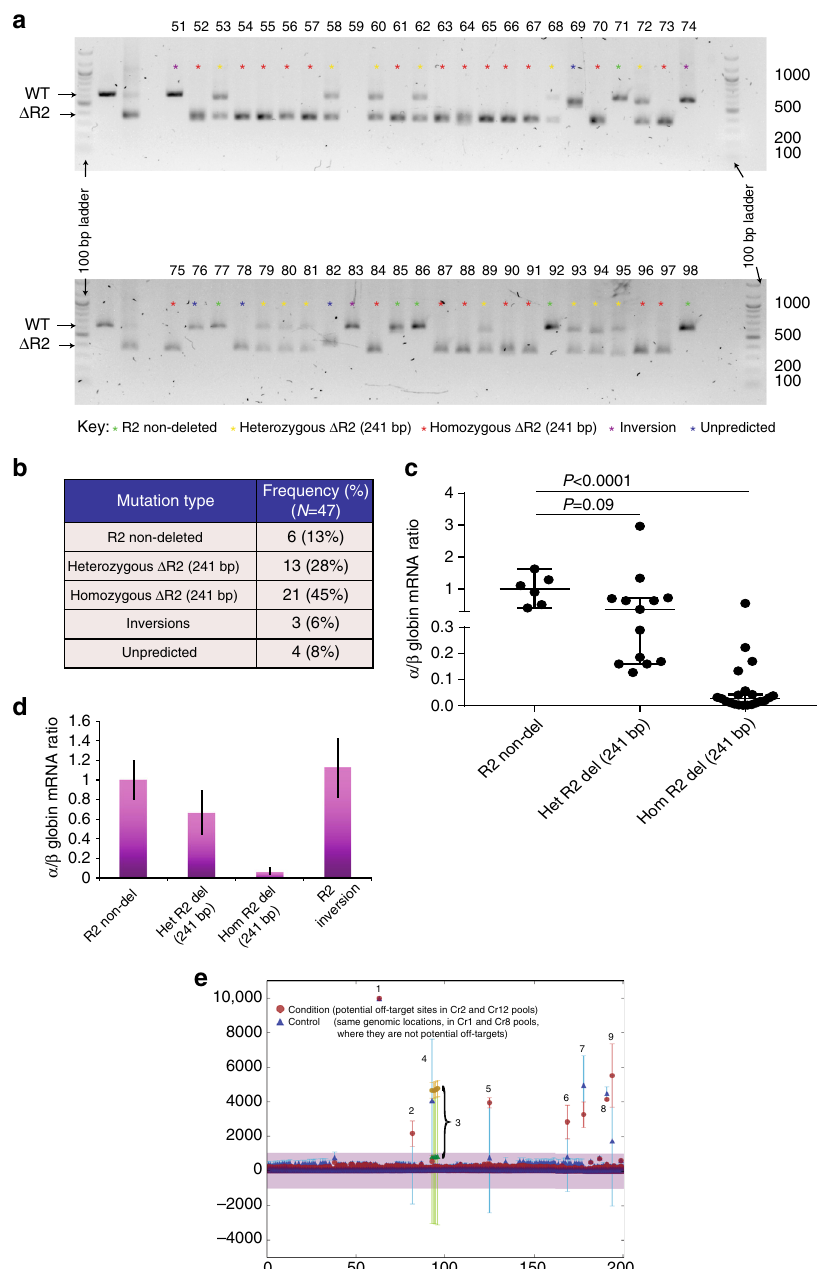
Fig. 3 Single-cell clone analysis of targeted deletion of MCS-R2. a Gel electrophoresis image of genomic DNA from 48 individual single-cell clones genome- edited using CRISPR pair Cr2 and Cr12 (from three biological independent donors) analyzed by PCR. The amplicon from the wild-type allele is 613 bp and the mutated amplicon is 372 bp. Clones are numbered 51 – 98 and clone 59 failed to amplify. Extended genotype analysis of these clones by sequencing is presented in Supplementary Fig. 4. b Frequency of different types of mutations generated. c α / β -globin mRNA ratios of individual clones of erythroid cells which are non-deleted (R2 non-del) ( n = 6) and heterozygous (Het R2 del.) ( n = 13) or homozygous (Hom R2 del.) ( n = 21) for a 241 bp deletion of MCS- R2 region analyzed by qPCR; median ( horizontal bar ) and 95% con fi dence interval ( error bar ) are shown and P -values were calculated using Mann – Whitney U -test. d α / β -globin mRNA ratios of erythroid cells, which has no deletion ( n = 6), heterozygous deletion ( n = 13), homozygous deletion ( n = 21), and inversion ( n = 3) of MCS-R2 analyzed by qPCR. Means and SEM are shown. e Meta-plot of all off-target loci for CRISPR pair Cr2 and Cr12. All captured sites are plotted on the same x -axis, showing ± 100 bases from each potential off-target site. Counts deviating from the reference sequence, which are normalized to 10,000 counts are plotted in the y -axis. The values are means of the libraries where each library is a pool of fi ve independent clones. The shaded violet area denotes ± 1000 counts and only data over this threshold were considered as off-target. Error bars represent SEM for each base at each locus. Potential off-target hits for Cr2 and Cr12 (condition) are plotted alongside those of a control group (control). The numbers are annotated in Supplementary Table 4. All of the variations from the reference sequence were shown to be known SNPs or indels or novel variations common to both control and condition and therefore unrelated to potential off-target